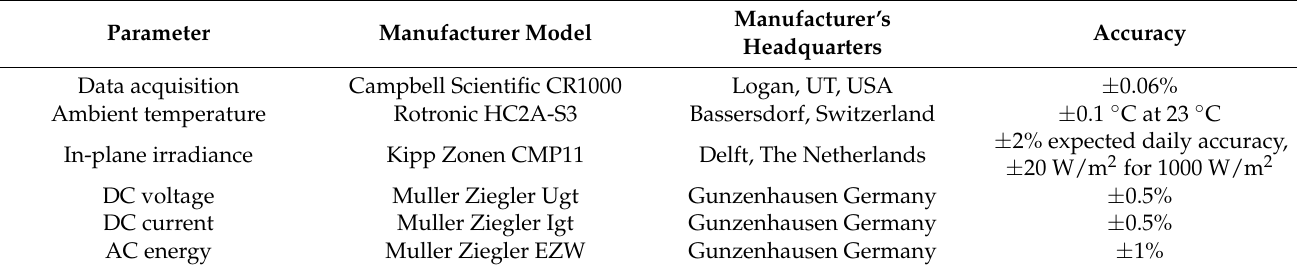
Table 1. Technical information of data acquisition (DAQ) system and sensor network.